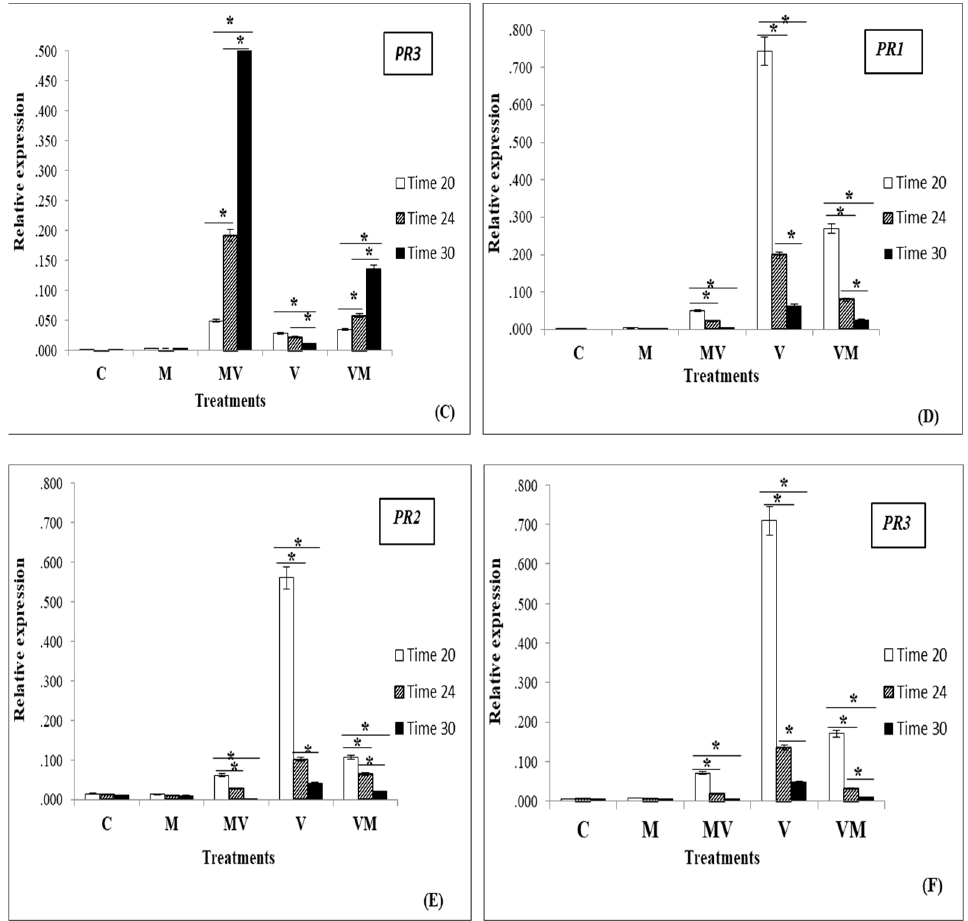
Figure 3. Expression analysis of PR1 , PR2 , PR3 genes by RT- qPCR for the plants infected by TBSV ( A – C ) and for the plants infected by ToMV ( D – F ). Uninfected control plants without AM fungi (C), uninfected control plants with AM fungi (M), TBSV/ToMV -infected plants without AM fungi (V), TBSV/ToMV-infected plants before mycorrhiza (VM) inoculation and inoculated plants with mycorrhiza before TBSV/ToMV infection (MV) at three stages of infection (20, 24 and 30 dpi). For each treatment, three replicates were tested. A significant difference between the expression of PR genes for each treatment in three different times is shown by (*) [using repeated measures ANOVA and Bonferroni post-hoc test ( p < 0.001)]. Error bars represent the SD.